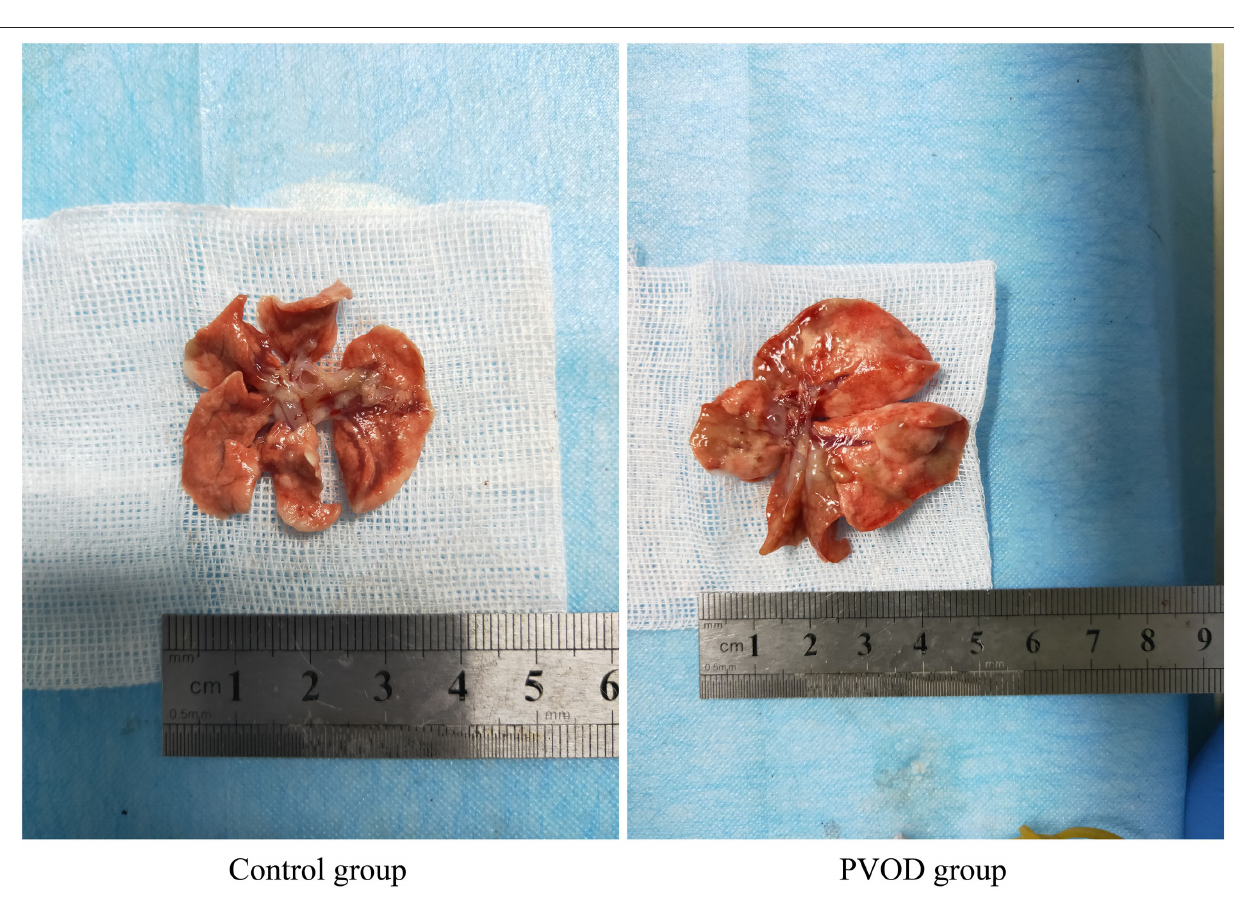
FIGURE 2 | The whole lung tissues in control and MMC-induced rat with PVOD. The lung tissue was significantly swollen, and also severe hyperemia and edema in the PVOD group compared with the control group. The control group ( n = 4 rats) and the PVOD group ( n = 10 rats). PVOD, pulmonary veno-occlusive